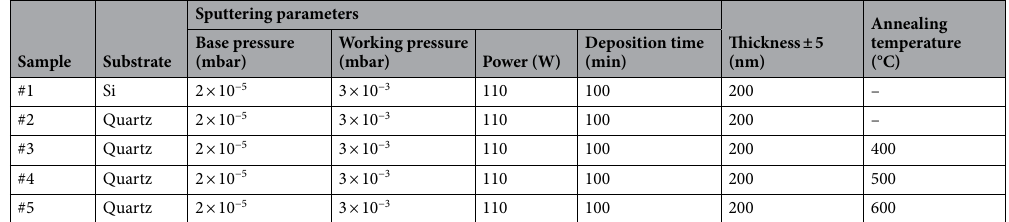
Table 1. Optimal conditions for RF reactive sputtering experiments for the deposition of NiO thin